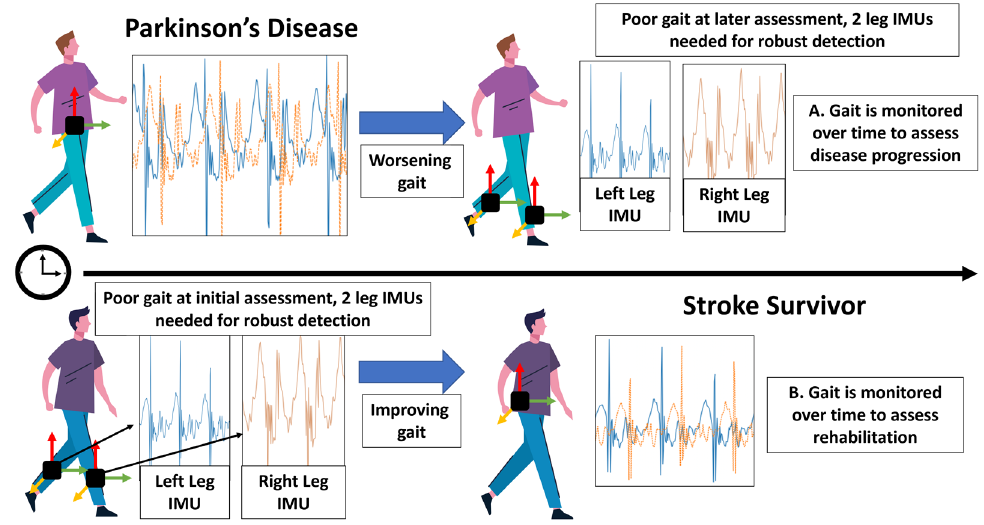
Figure 1. In prescribing IMUs for gait assessment, one size may not fit all. Considerations of placement selection between PD and stroke, where different colored signals represent examples of different sensing axes of acceleration. Top: use of a single IMU on the lower back is useful in early PD to detect, e.g., gait variability, but a single IMU may not be fit for purpose as gait worsens. Accordingly, use of two IMUs on the legs may be more appropriate to detect slower, shuffling gait often seen in advanced PD. Bottom: a contrasting example, IMUs placed on the legs of a recent stroke survivor may be more optimal for gait assessment compared to the lower back. As gait for this person improves though a rehabilitation program, use of a single IMU may be more optimal and pragmatic.